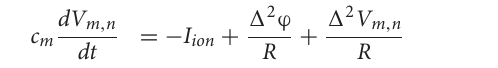
Frontiers in Neuroscience |